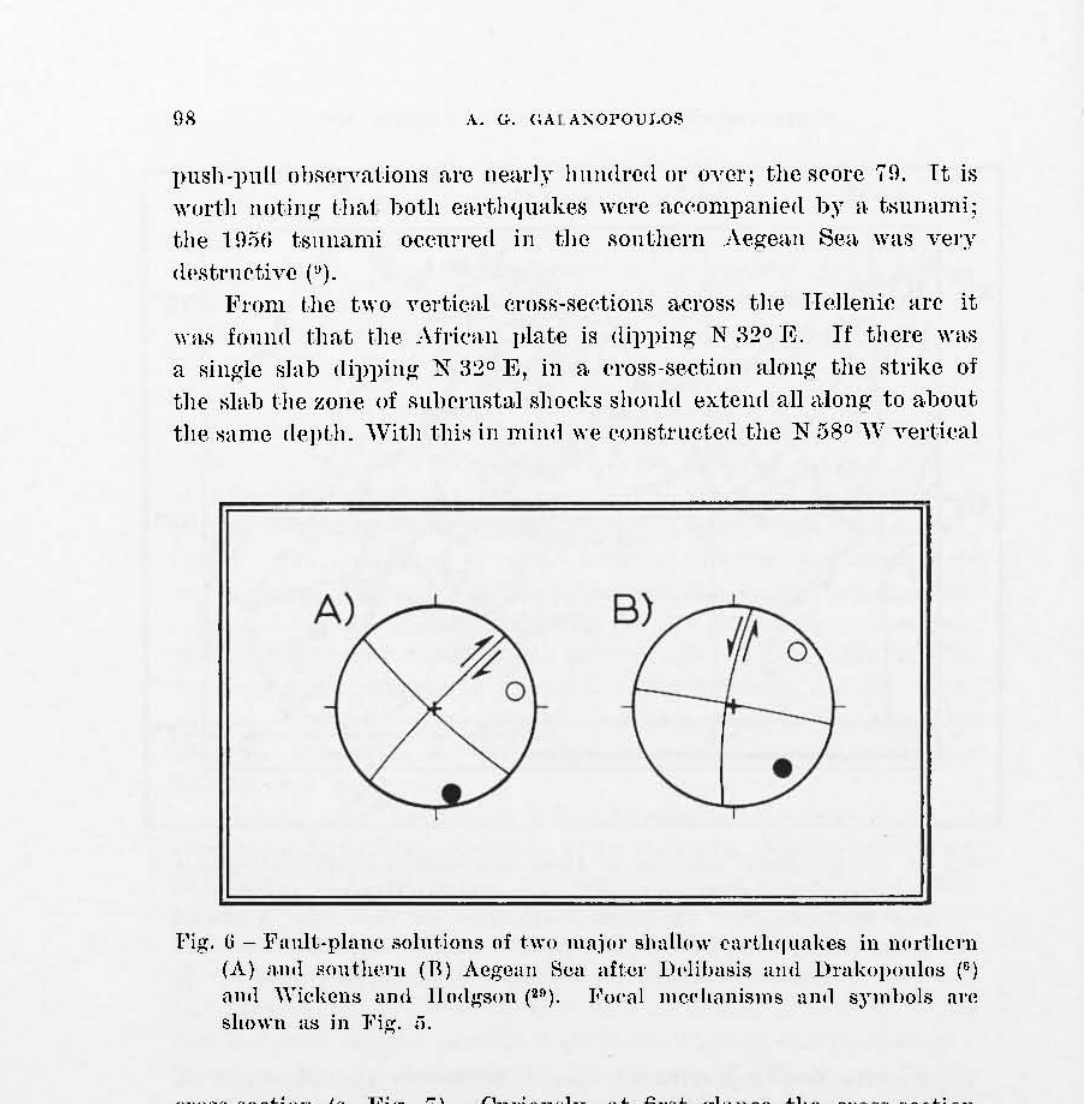
Fig. (j -li'alllt.plalle .~Ollltiolls of two lllnjol' shaliow eal'thqunkes in northel'n (A) allOl ~OlltlU.'l·1l (H) Aegeall Rea aft(JJ' 1ll'liba8is alld llra}.;:oJlolllos (") illlOl \Yiekens and lI(HIg-soll (IO). FO('ill llle<,hilniSlllS an,l s:rlllhols al'(~ showll as in Tig-.